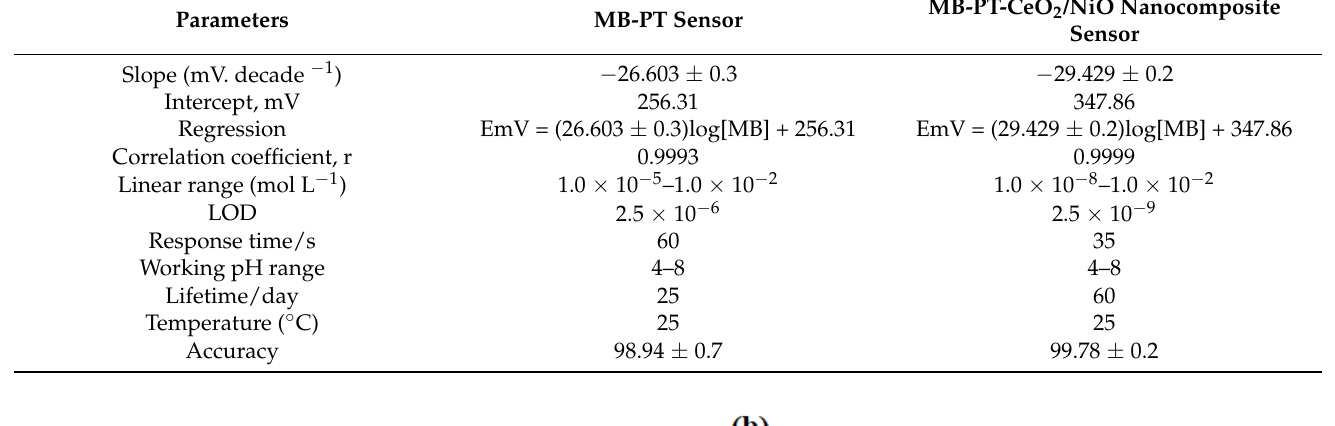
Table 1. The potential performance features of MB-PT and MB-PT-CeO 2 /NiO nanocomposite sensors.